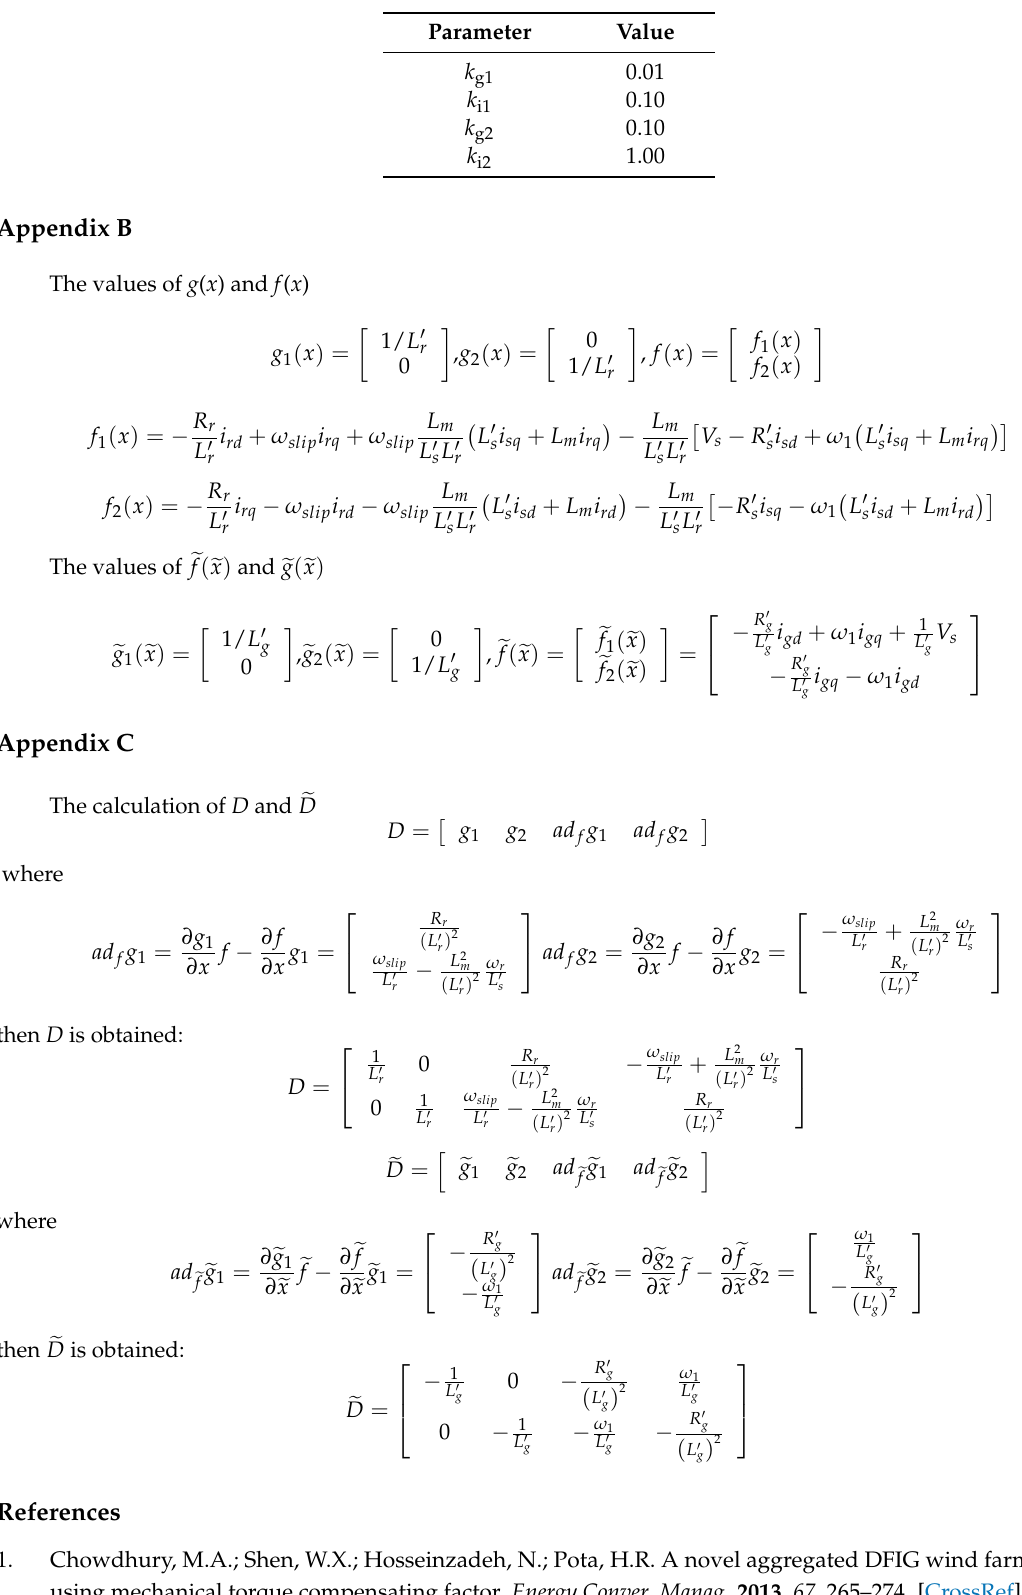
Table A2. PI parameters of the rotor side